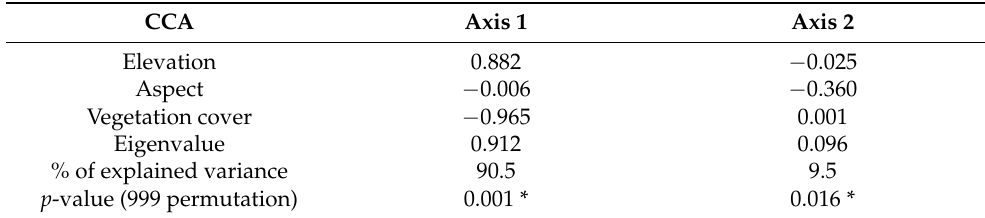
Table 2. Canonical correspondence analysis (CCA) scores of the environmental variables and per- centage of explained variance. CCA Axis 1 Axis 2 Elevation 0.882 − 0.025 Aspect − 0.006 − 0.360 Vegetation cover − 0.965 0.001 Eigenvalue 0.912 0.096 % of explained variance 90.5 9.5 p -value (999 permutation) 0.001 * 0.016